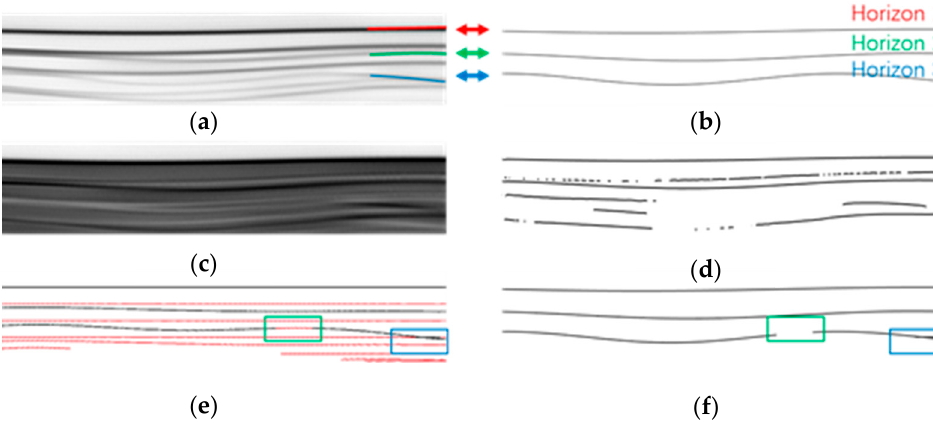
Figure 20. Multiples suppression results of the synthetic experiment. ( a ) The virtual SBP image. ( b ) The ground truth. ( c ) The image after the predictive deconvolution in which the predictive step is the instantaneous seawater depth. ( d ) The extracted horizons using the FrangiV algorithm for ( c ). ( e ) The identification results by the proposed method. The red lines represent multiples, and the black are horizons. ( f ) The extracted horizons using the proposed method. It is an image that removes multiples (red lines) from ( e ). The green rectangle represents the location where the horizons are missing. The blue rectangle represents the position where the nonexistent horizons appear. Table 3. The accuracy comparison.